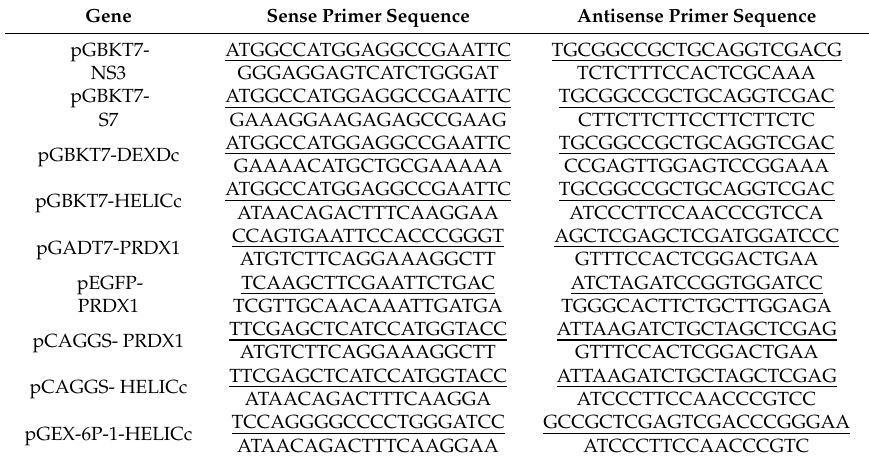
Table 1. Primers for construction of recombinant